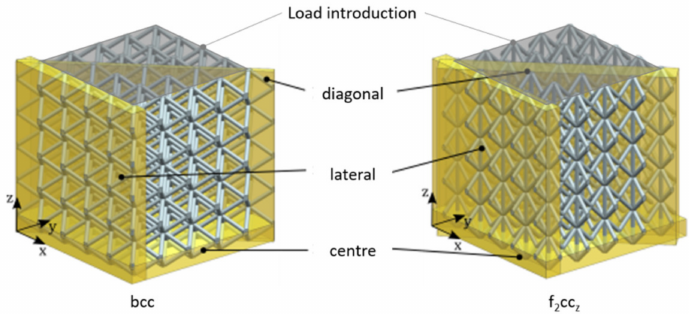
Figure 5. Selected view cuts.